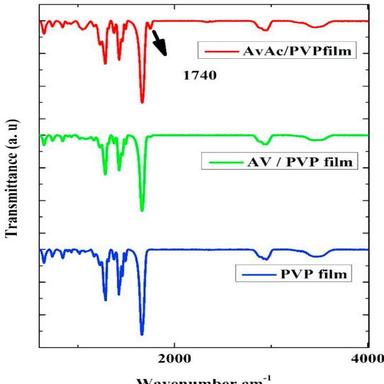
FT-IR spectra of Av/PVP, AvAc/PVP nanofibers.